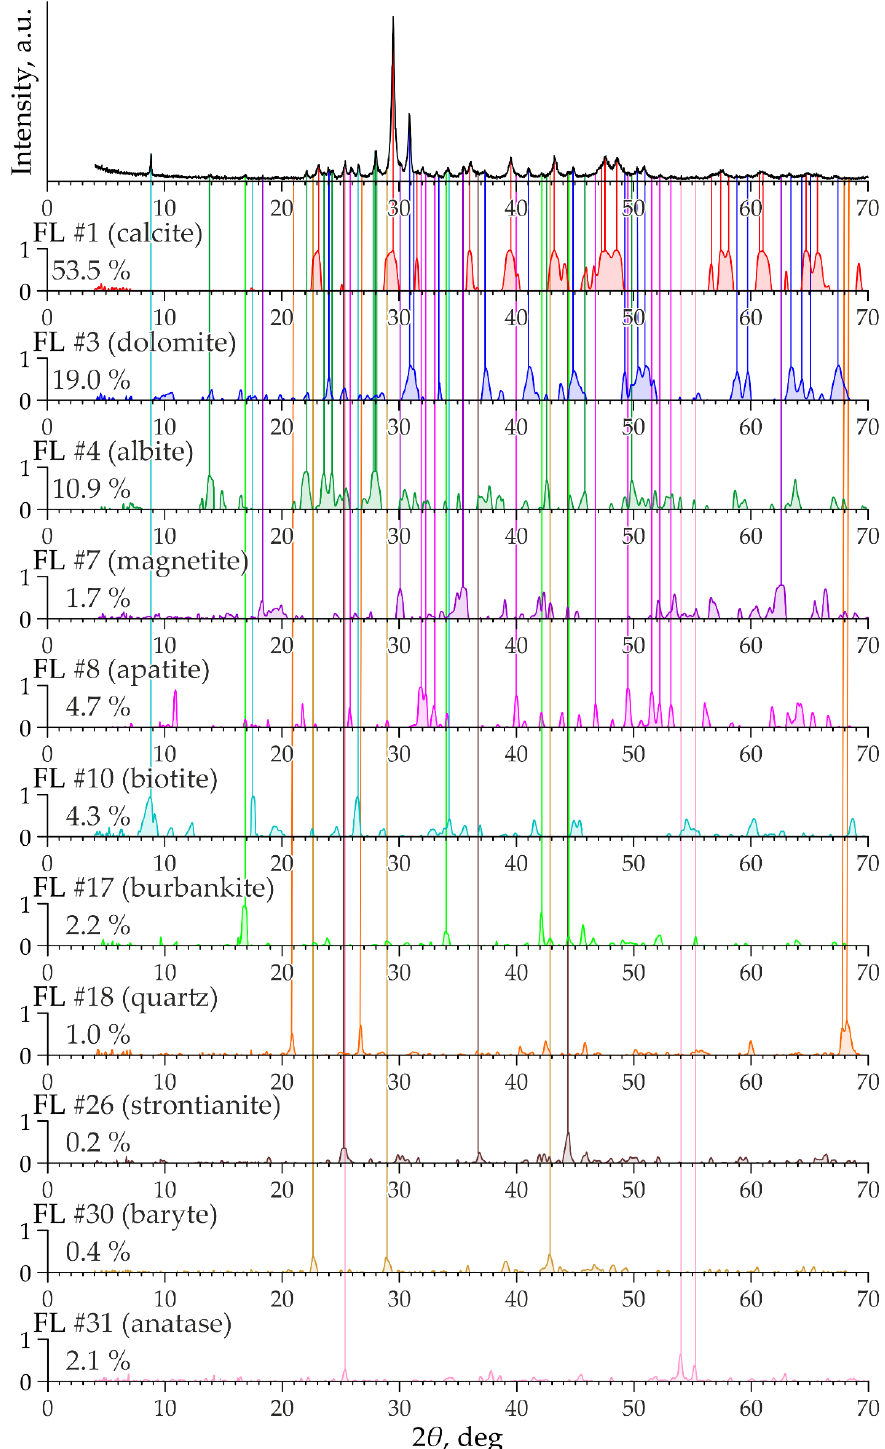
Figure 1. Comparison of the diffraction pattern of an exemplary sample with the factor loading ( FL ) graphs of factors of the minerals constituting this sample (quantitative analysis was performed using the MAUD program [19,20]).